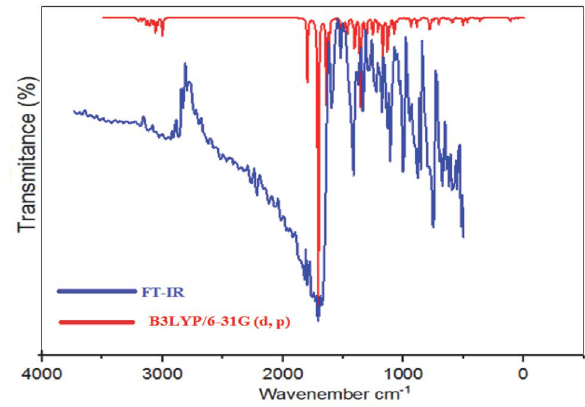
Figure 4. Comparison of FT-IR and calculated IR Spectra for ( Z )-3- N -(ethyl)-2- N ’-((3-methoxyphenyl)imino)thiazolidine-4-one.